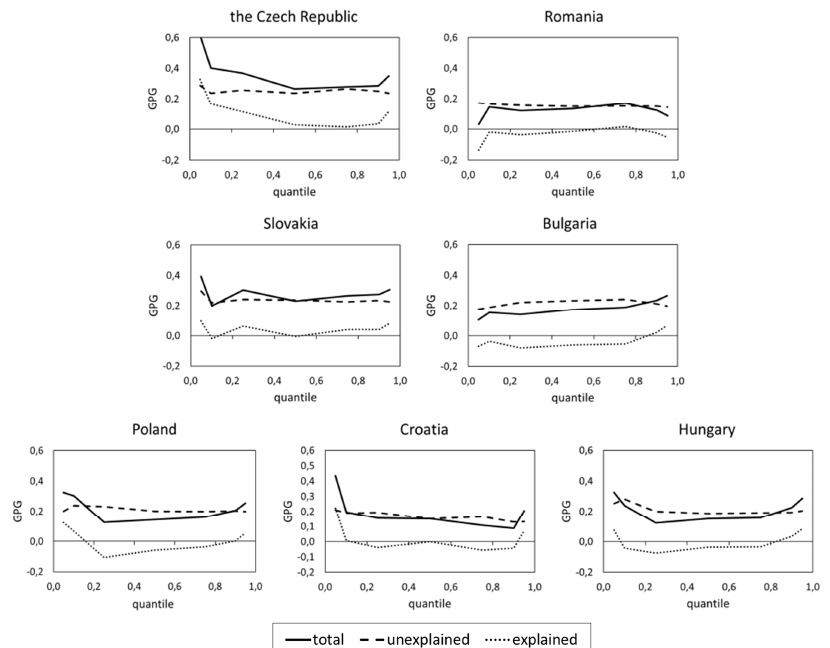
Figure 3. The differences between the log income distributions for men and women vs. quantile rank in the group